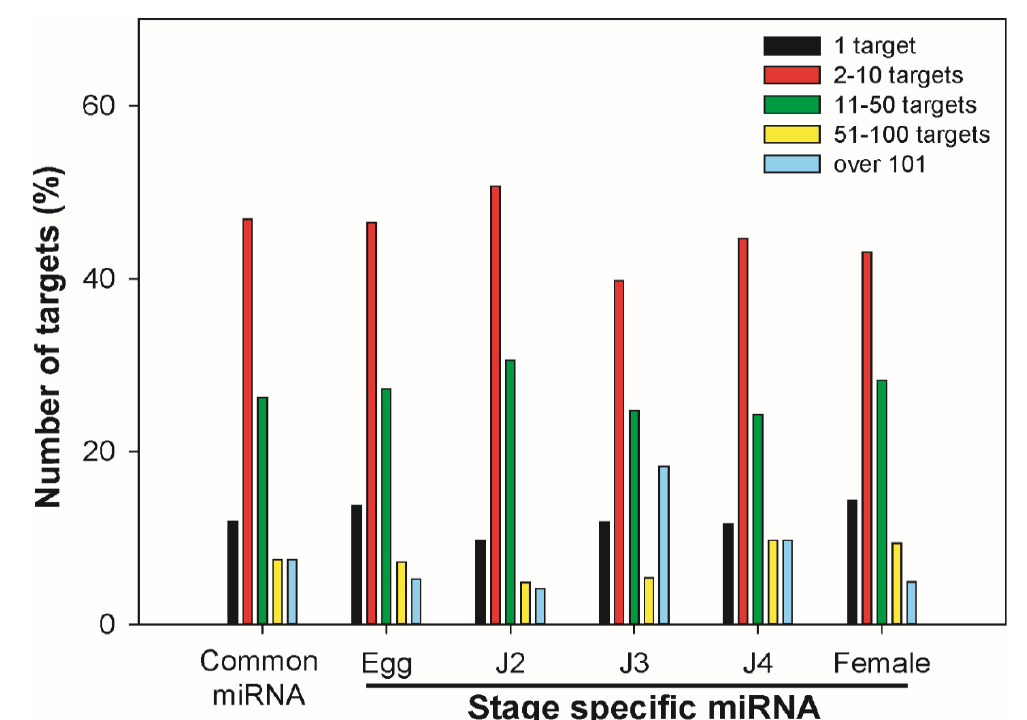
Figure 6. Percentage chart showing the number of mRNA targets of miRNAs expressed in M. incognita . The number of targets for each miRNA was determined at all stages, and the most miRNAs were found to target 2–10 mRNA sequences. The second highest percentage was for miRNAs targeting 11–50 mRNA. These results indicated high target range diversity among miRNAs.